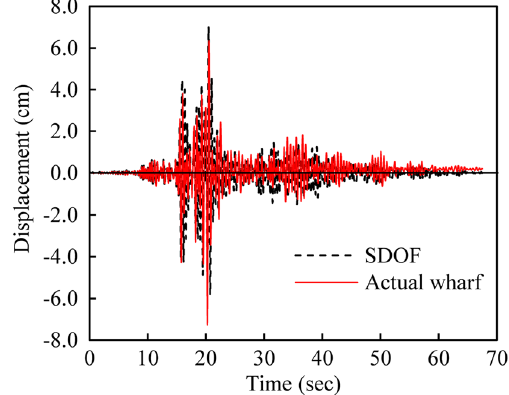
Fig. 11 Displacement demands for case study II